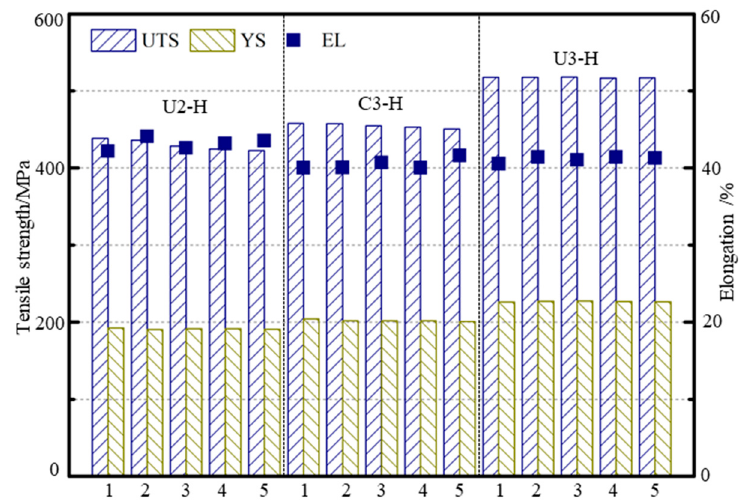
Figure 16. E ff ect of location on tensile properties and elongation of deposited metal in di ff erent regions Figure 16. Effect of location on tensile properties and elongation of deposited metal in different of the corresponding Figure regions of the corresponding Figure 1c.